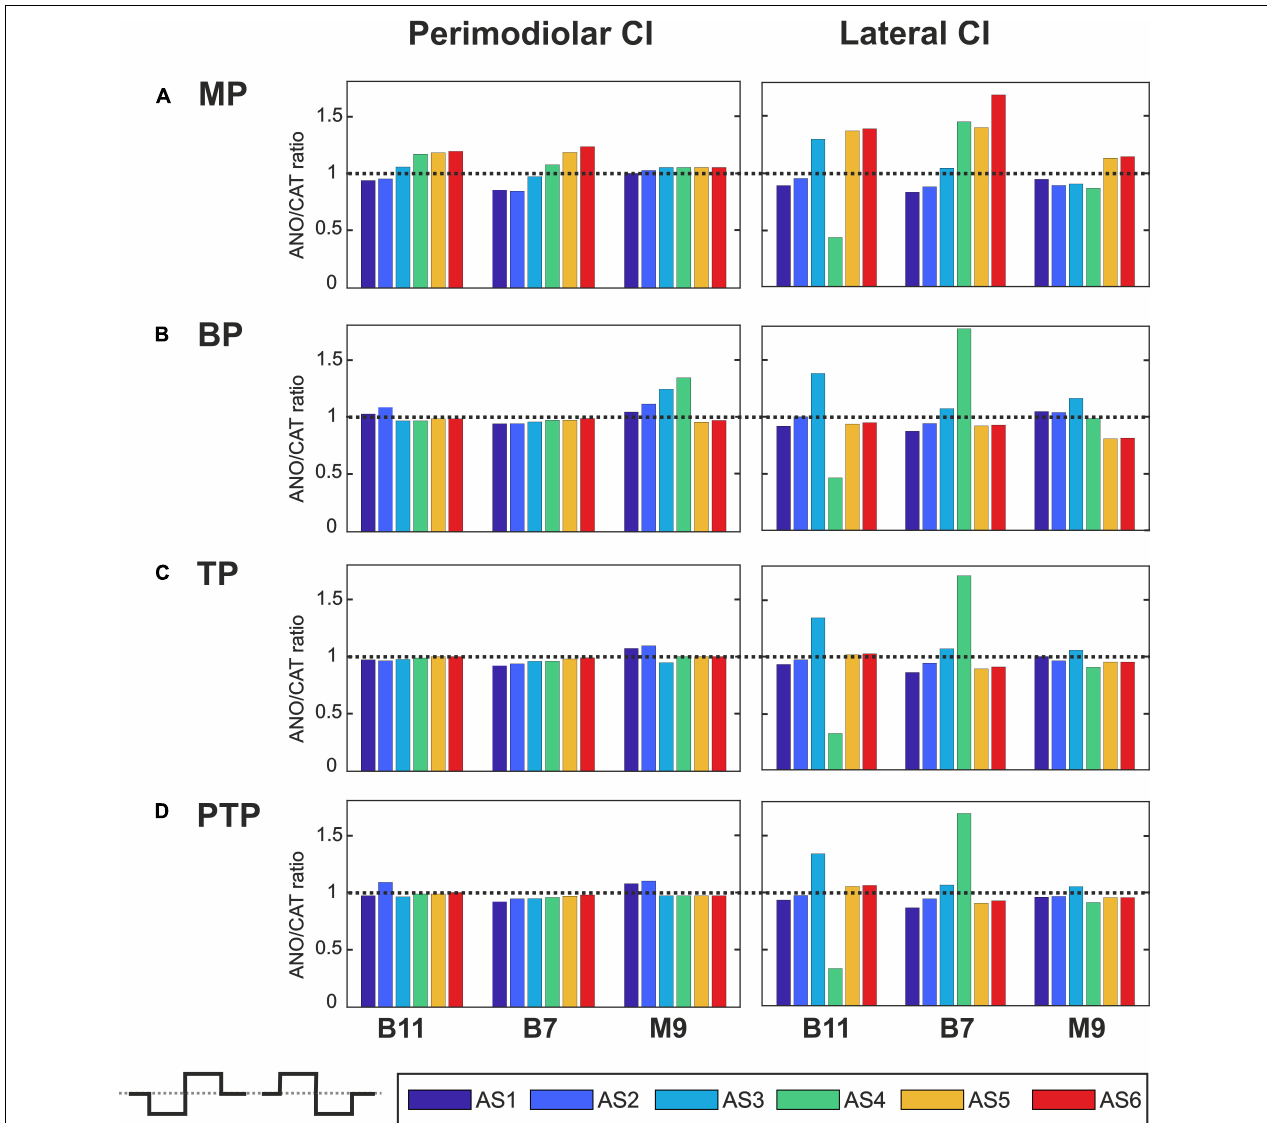
FIGURE 10 | Polarity ratios for different degeneration levels stimulated with the biphasic pulse. Layout as in Figure 7 .